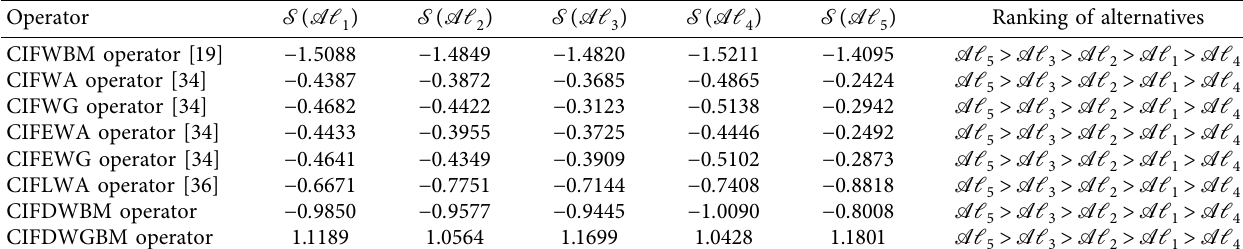
Table 8: Analysis result of comparative studies of the proposed operators with existing methods. Operator S ( Al 1